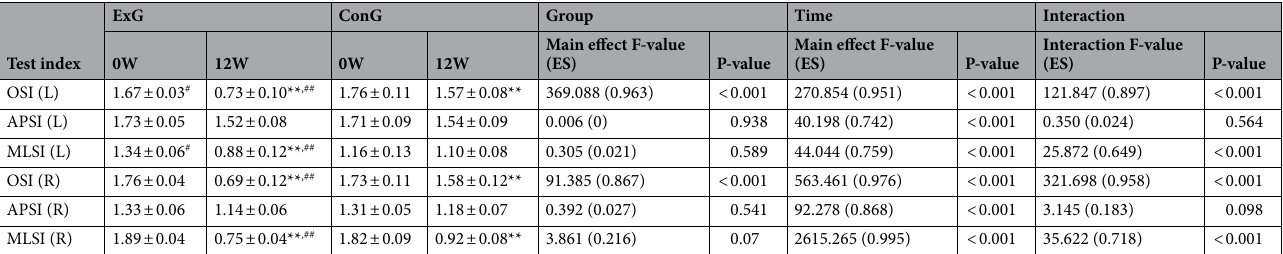
Table 6. Subjects’ single-leg stability test (SLST) 2 × 2 repeated measures ANOVA test. Within-group differences *P < 0.05, **P < 0.01; Differences between groups # P < 0.05, ## P < 0.01.